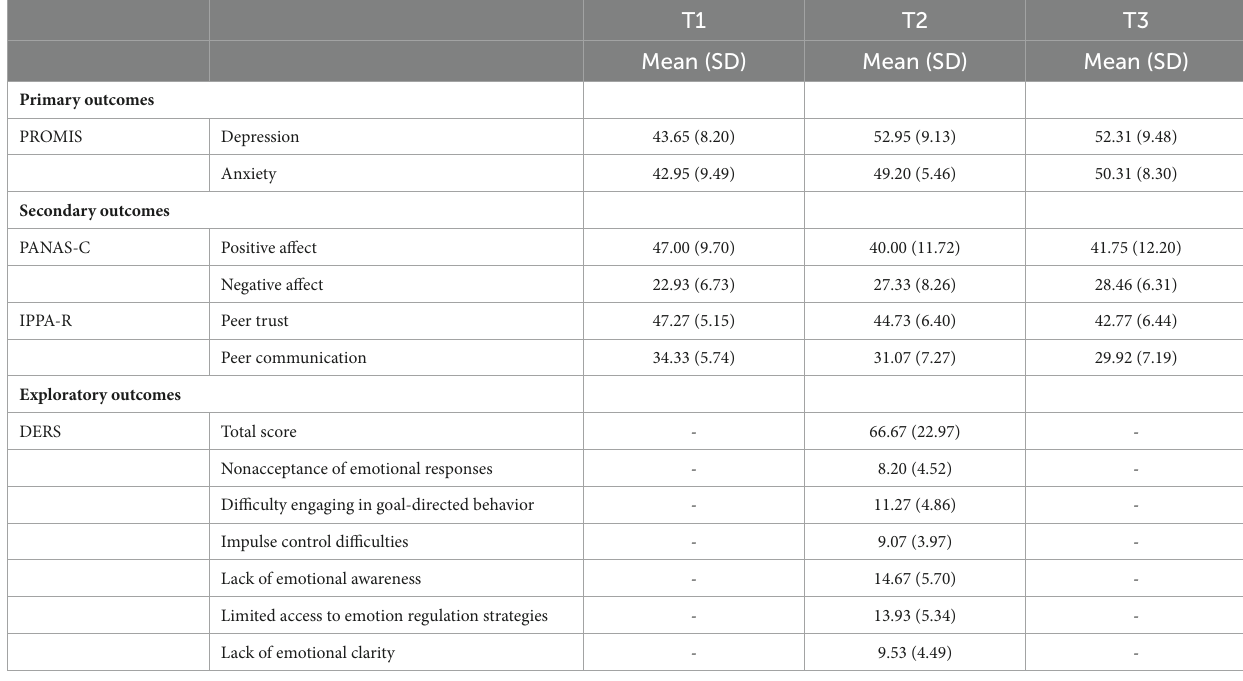
TABLE 2 Outcomes at pre-pandemic (T1), early pandemic (T2), and later pandemic